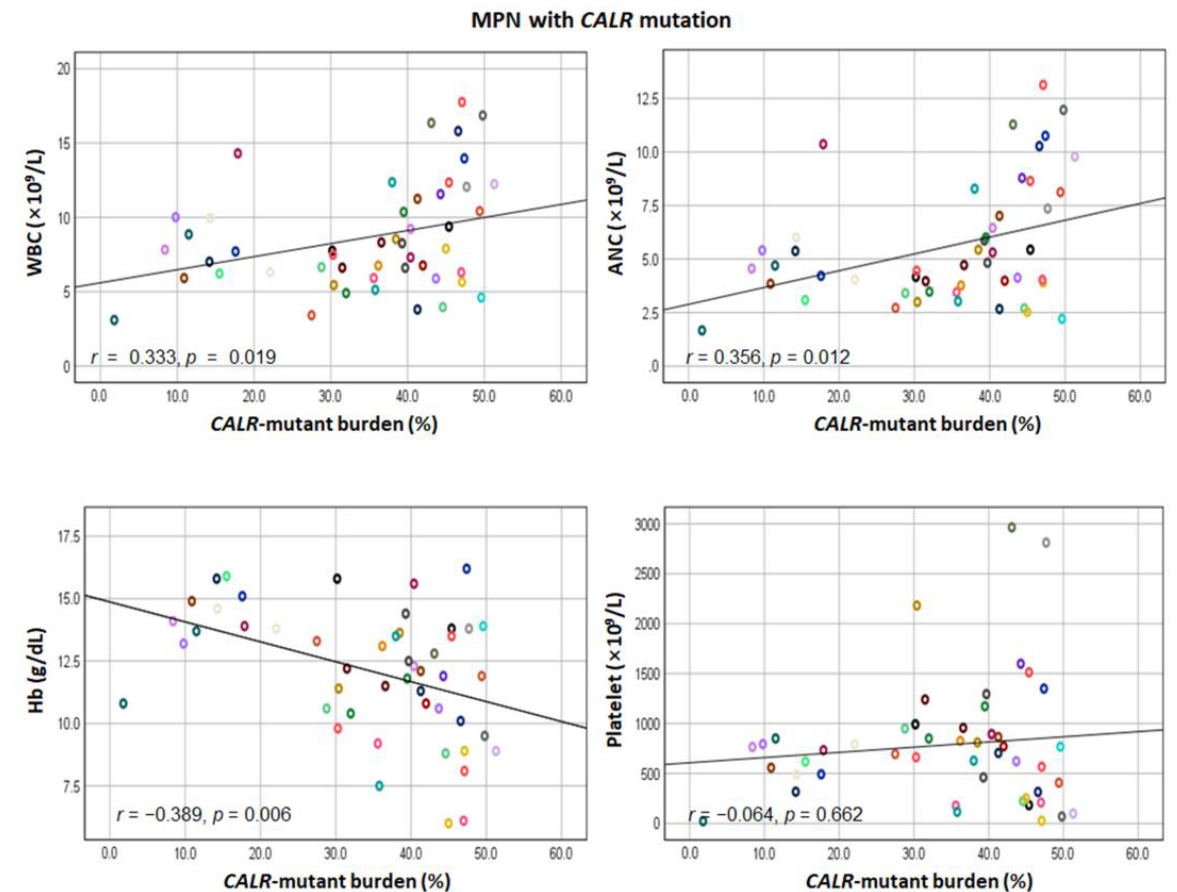
Figure 1. Scatter plots between CALR -mutant burden and white blood cell (WBC) count, absolute neutrophil count (ANC), hemoglobin (Hb) level, and platelet count in 49 MPN patients with CALR mutation. Circles of the same color indicate the same patient.